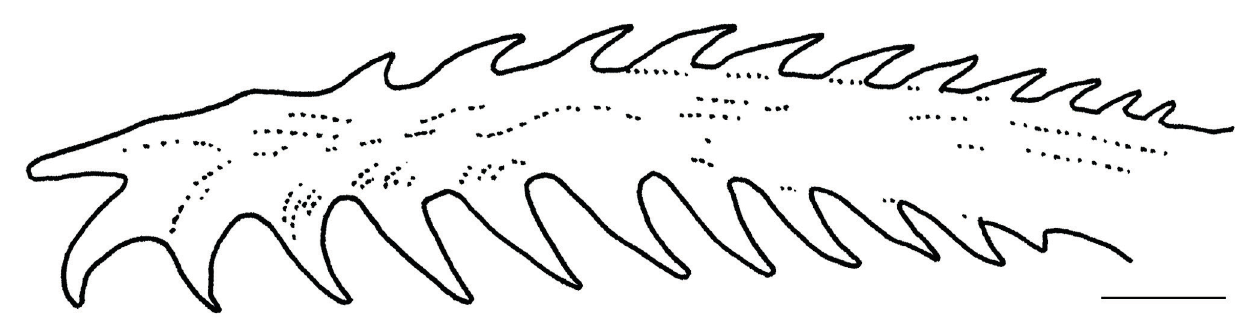
FIGURE 2 | Rhyacoglanis varii pectoral-fin spine, paratype, MZUEL 6039, 55.5 mm SL. Scale bar = 1.0